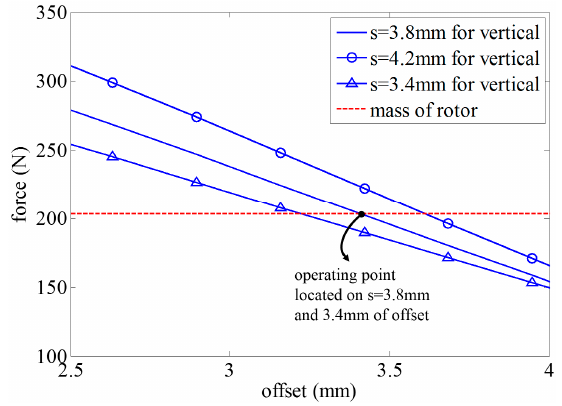
Figure 10. The moments caused by the vertical force f pv of 16 sets of passive magnetic units about X -axis and Y -axis.